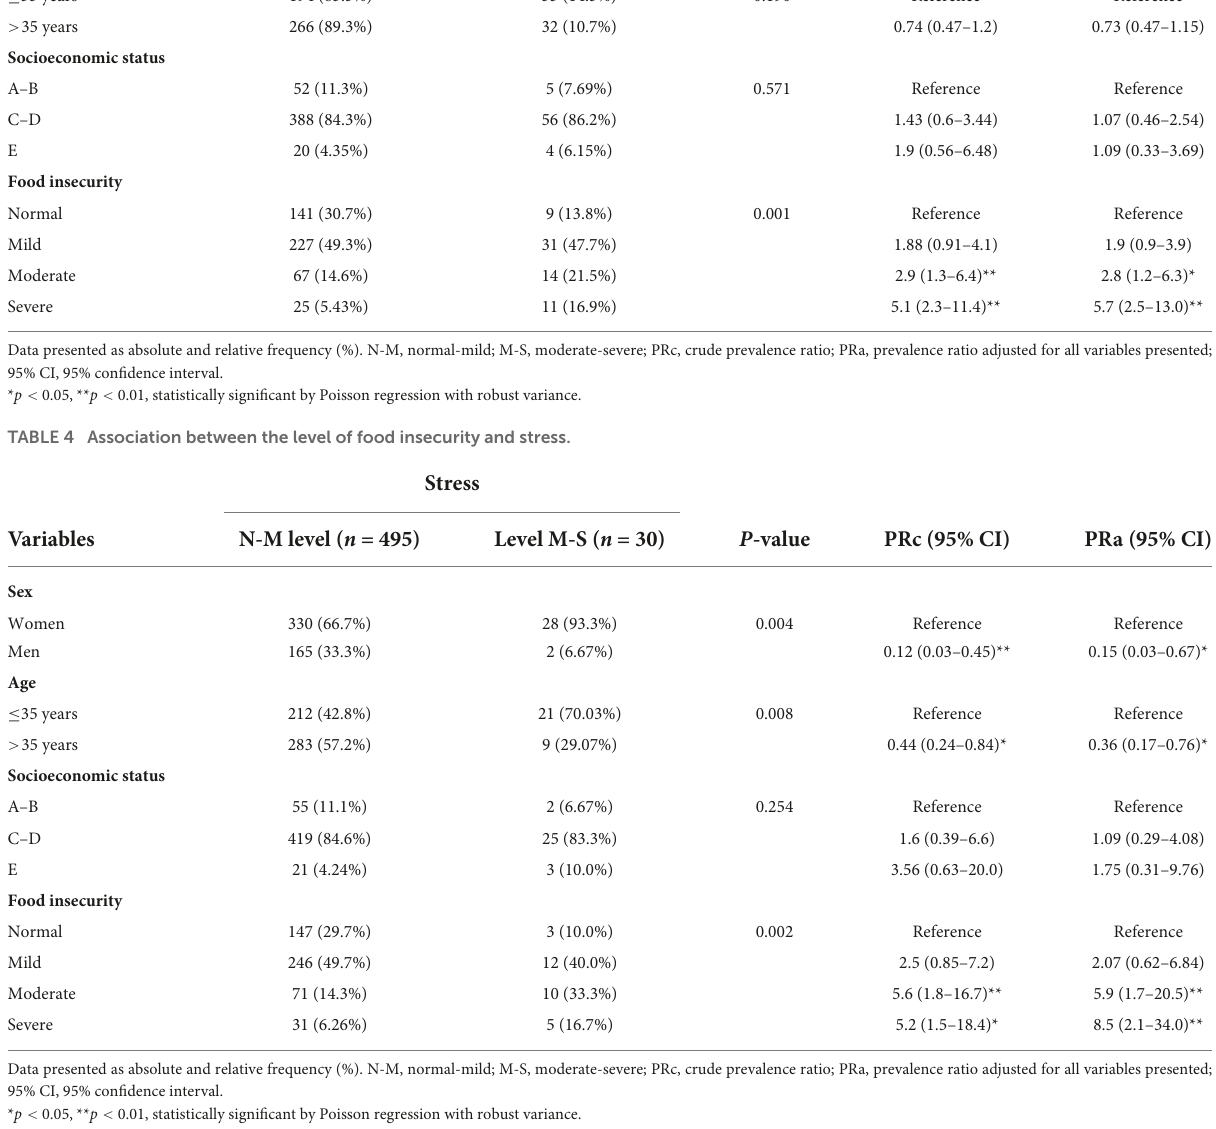
TABLE 3 Association between level of food insecurity and depression.